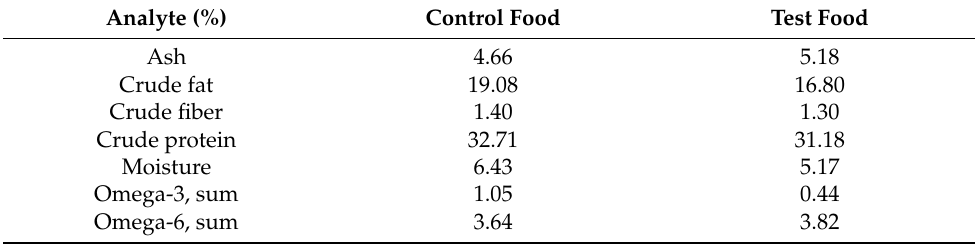
Table 1. Proximate analysis of foods used in this